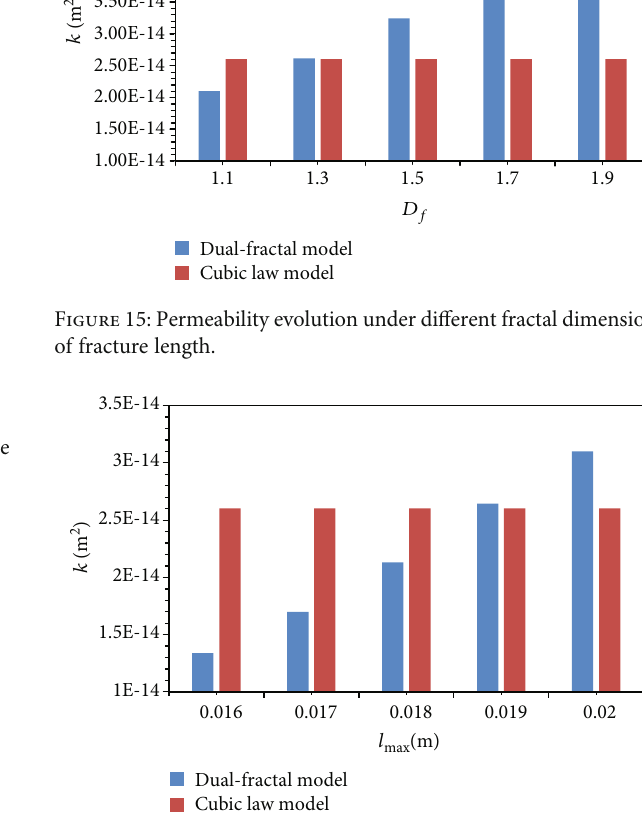
Figure 16: Permeability evolution under di ff erent maximum fracture